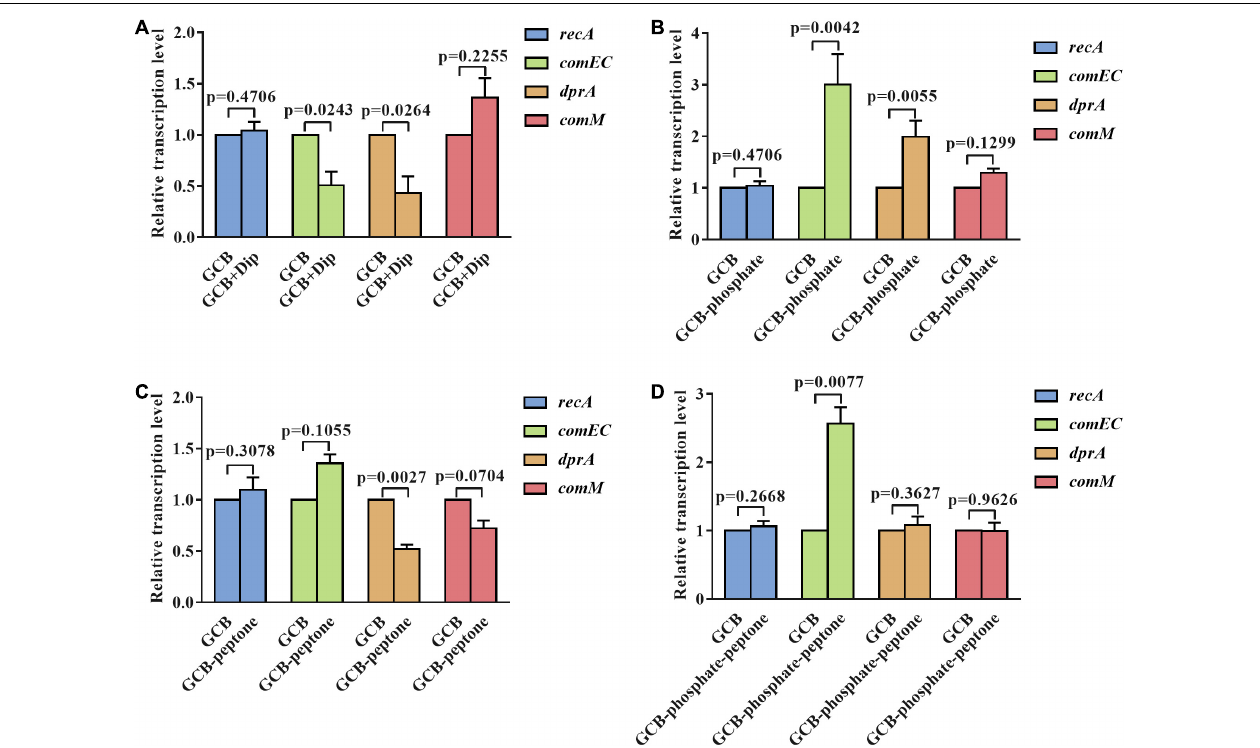
FIGURE 4 | The transcriptional levels of dprA, comEC, recA , and comM in R. anatipestifer ATCC 11845 under different nutrient-limited conditions. (A) Quantitative real-time PCR analysis of the relative transcription of dprA , comEC , recA , and comM in R. anatipestifer ATCC 11845 in the GCB medium and GCB containing 100 µ M Dip as described in section “Materials and Methods.” (B) Quantitative real-time PCR analysis of the relative transcription of dprA , comEC , recA , and comM in R. anatipestifer ATCC 11845 in GCB and GCB without phosphate as described in section “Materials and Methods.” (C) Quantitative real-time PCR analysis of the relative transcription of dprA , comEC , recA , and comM in R. anatipestifer ATCC 11845 in GCB and GCB without peptone as described in section “Materials and Methods.” (D) Quantitative real-time PCR analysis of the relative transcription of dprA , comEC , recA , and comM in R. anatipestifer ATCC 11845 in GCB and GCB without phosphate and peptone as described in section “Materials and Methods.” Fold changes were calculated by the (cid:49) (cid:49) Ct method to consider the efficiency of the PCR for each target gene.